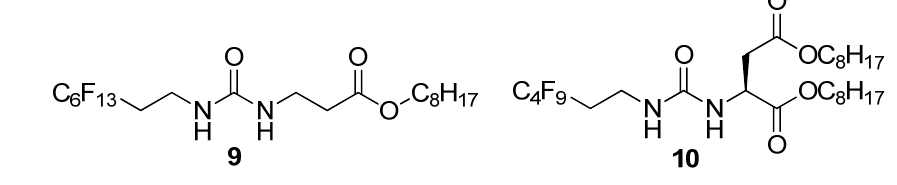
Figure 3. Urea-ester derivatives from N -Boc- β -alanine and N -Boc-L-aspartic acid.